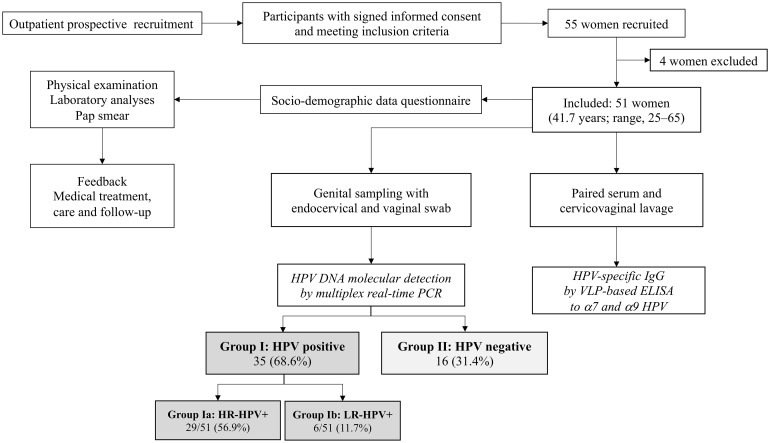
Flow diagram of the ImmiPap study.Three biological samples were obtained for study analyses, including a serum sample, a genital swab of endocervix and vaginal walls, and a standardized cervicovaginal lavage with 3 mL of PBS. HPV DNA detection was carried out on nucleic acid extracted from swab-collected genital secretions by multiplex Anyplex™ II HPV28 real-time PCR (Seegene, Seoul, Korea). The group I of study women showed HPV DNA in their genital secretions, including HR-HPV DNA with or without associated LR-HPV (group Ia) or exclusively LR-HPV DNA (group Ib); the group II of study women did not show detectable HPV DNA in their genital secretions. The paired serum and acellular part of cervicovaginal lavage samples were analyzed for serum and genital HPV-specific IgG, respectively, using virus-like particles-based indirect ELISA assay against HR-HPV belonging to α7 (HPV-18, -45 and -68) and α9 (HPV-16, -31, -33, -35, -52 and -58) groups. ELISA: Enzyme-linked immunosorbent assay; HR-HPV: High risk-HPV; LR-HPV: Low risk-HPV.